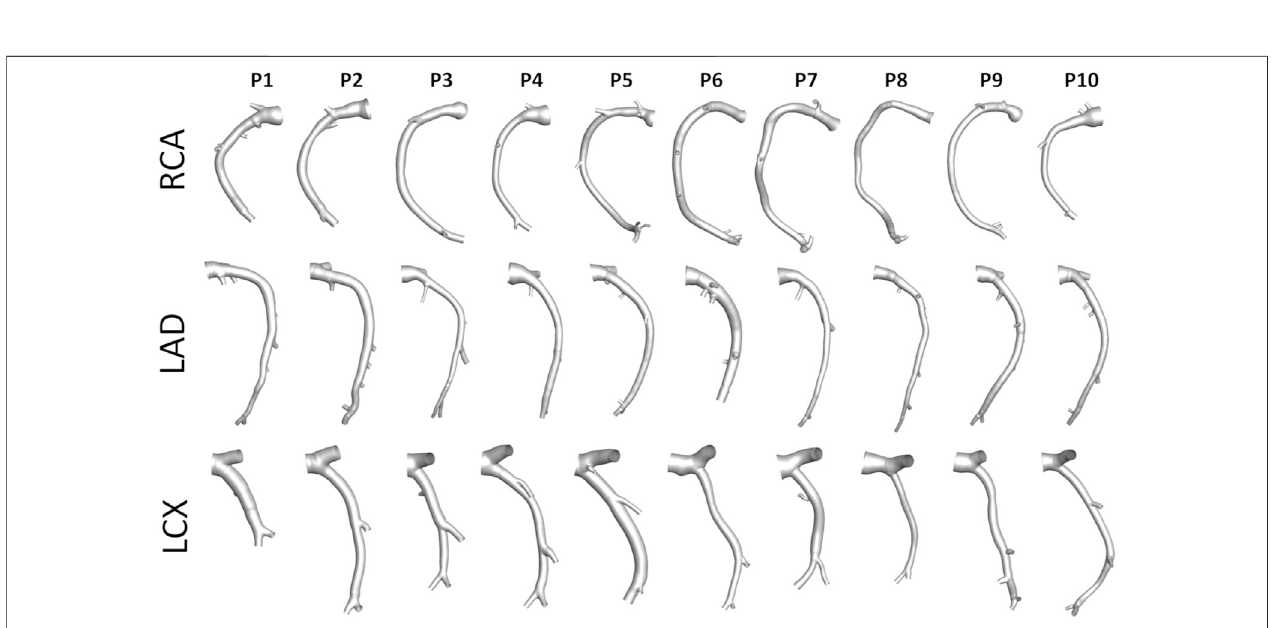
FIGURE 3 | Geometry of the 30 swine coronary artery models. Labels from P1 to P10 identify the single pig. Right (RCA), left anterior descending (LAD), and left circum fl ex (LCX) coronary artery geometries are grouped.